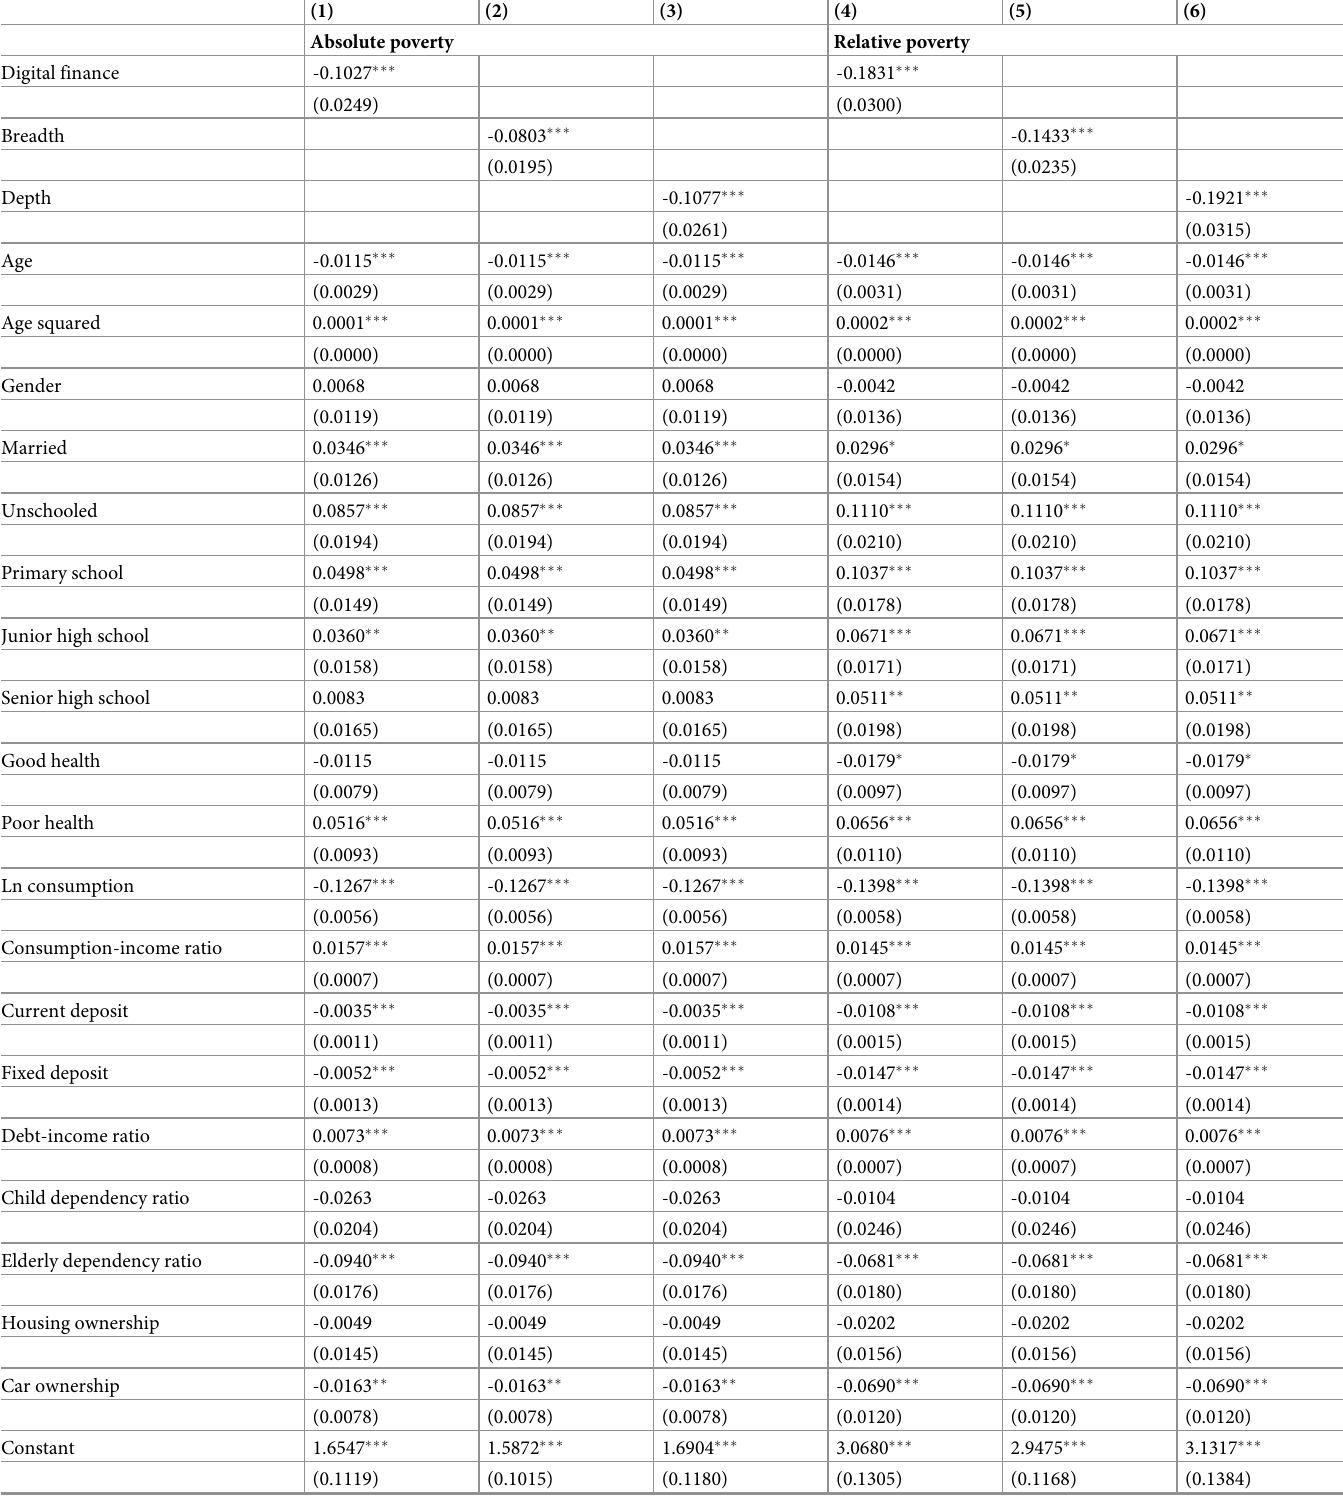
Table 3. The impact of digital finance on rural household